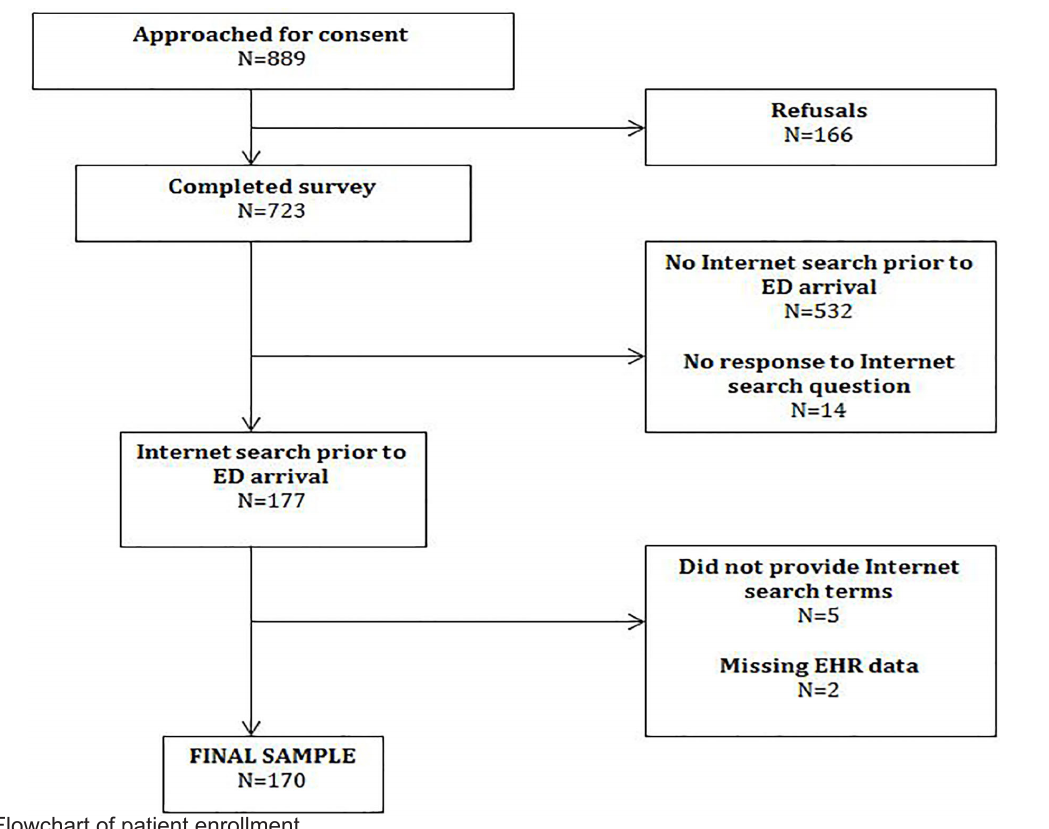
Figure. Flowchart of patient